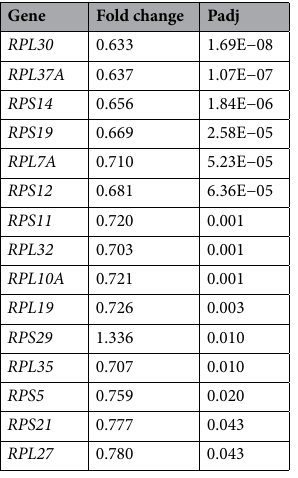
Table 4. Expression of ribosomal proteins from RNA seq data.